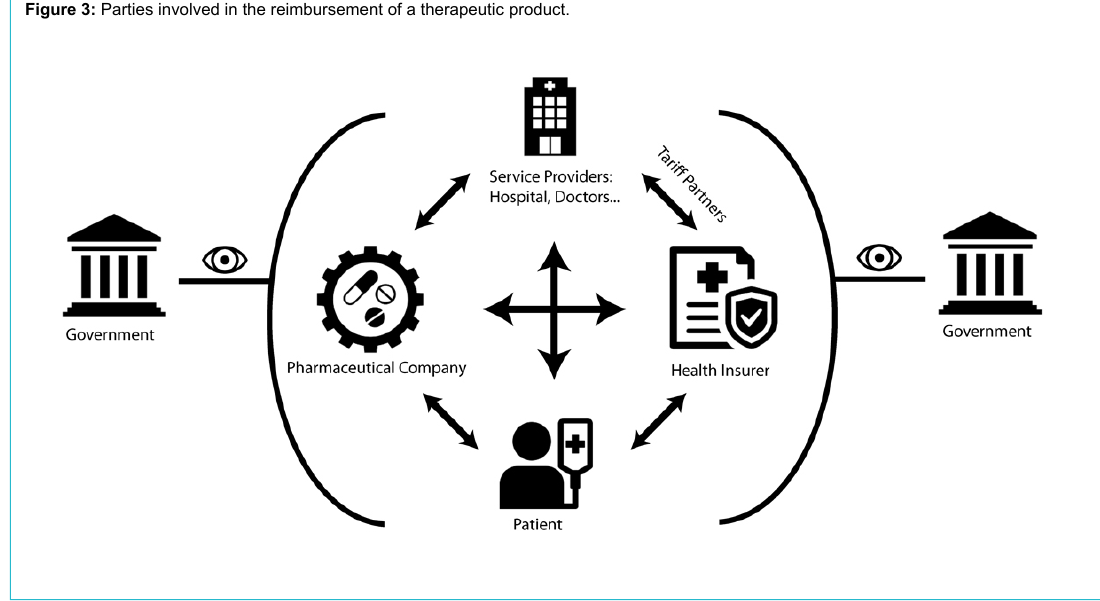
Figure 3: Parties involved in the reimbursement of a therapeutic